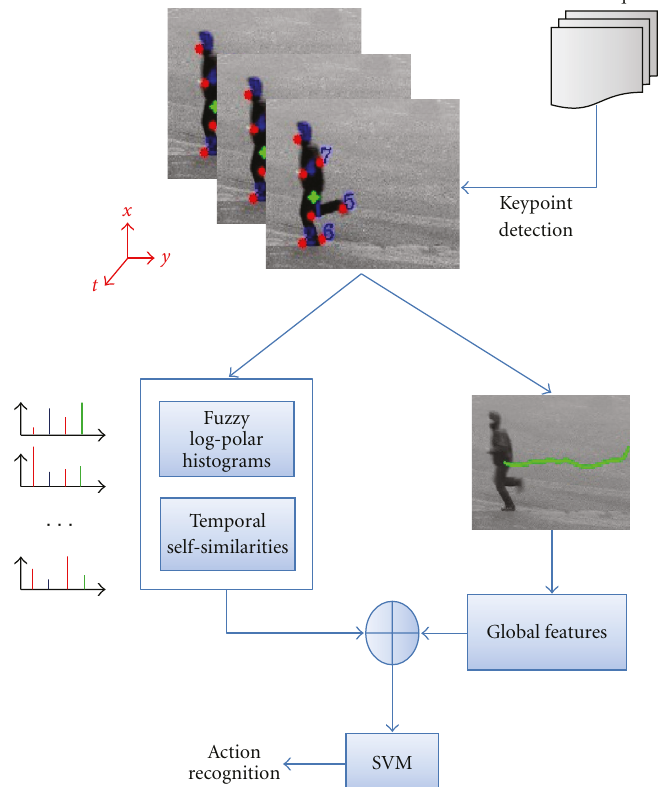
Figure 1: Block diagram of our fuzzy action recognizer.